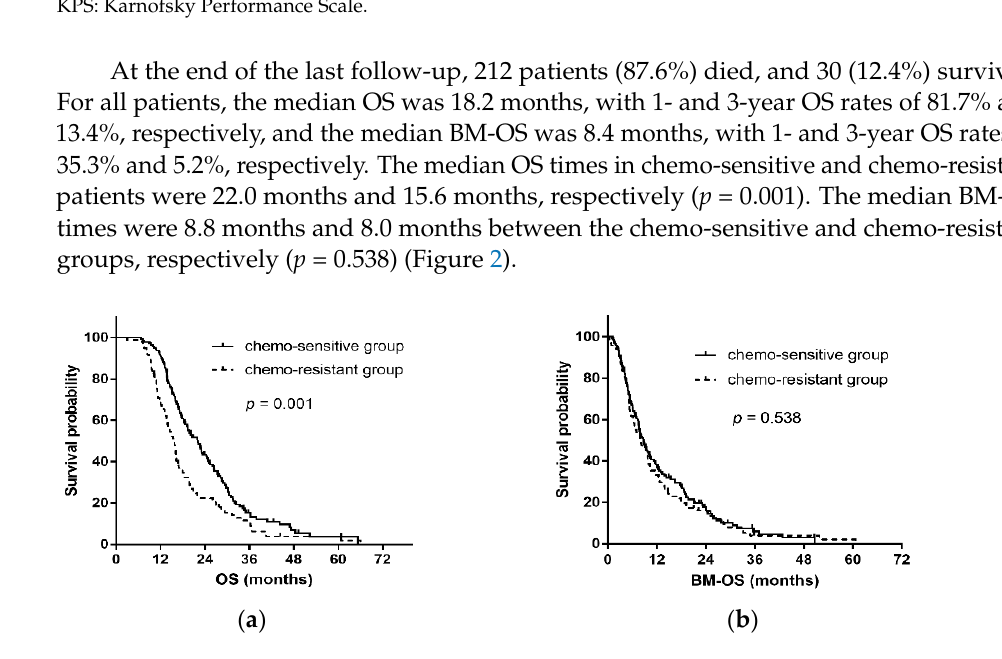
Figure 2. Kaplan–Meier curves for overall survival and survival time after BM in all patients between two groups. ( a ) Overall survival; ( b ) Survival time after BM. BM: brain metastasis.